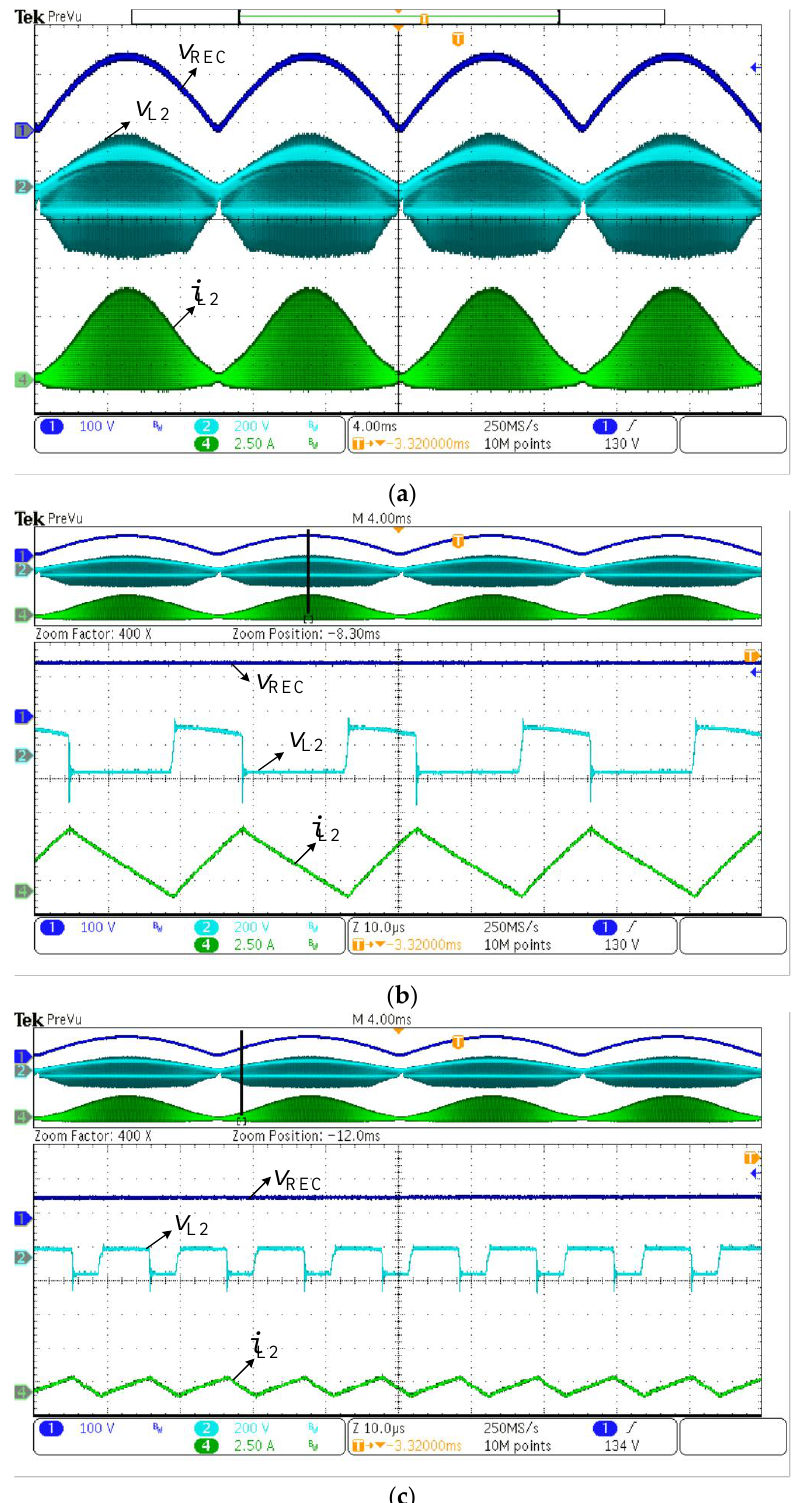
Figure 23. Experimental waveforms of v REC , v L 1 , and i L 1 of VOT control with 110 Vac input voltage and rated current load. ( a ) overall waveform; ( b ) zoomed-in waveform at ωt = π/2, i.e., v Rec is 155 V; ( c ) zoomed-in waveform around zero-cross point of input voltage, v Rec is 50 V.